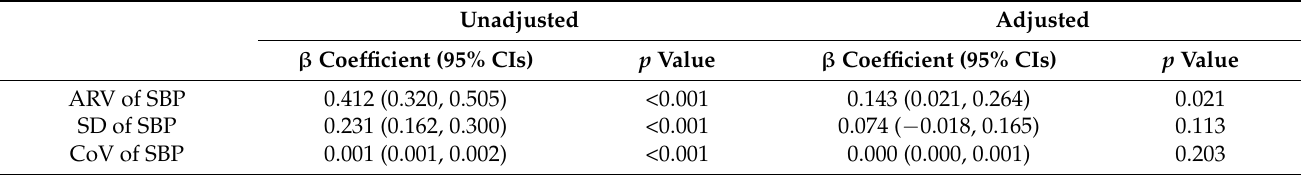
Table 2. Multivariate linear regression analyses of serum OPG level (per pmol/L) for systolic